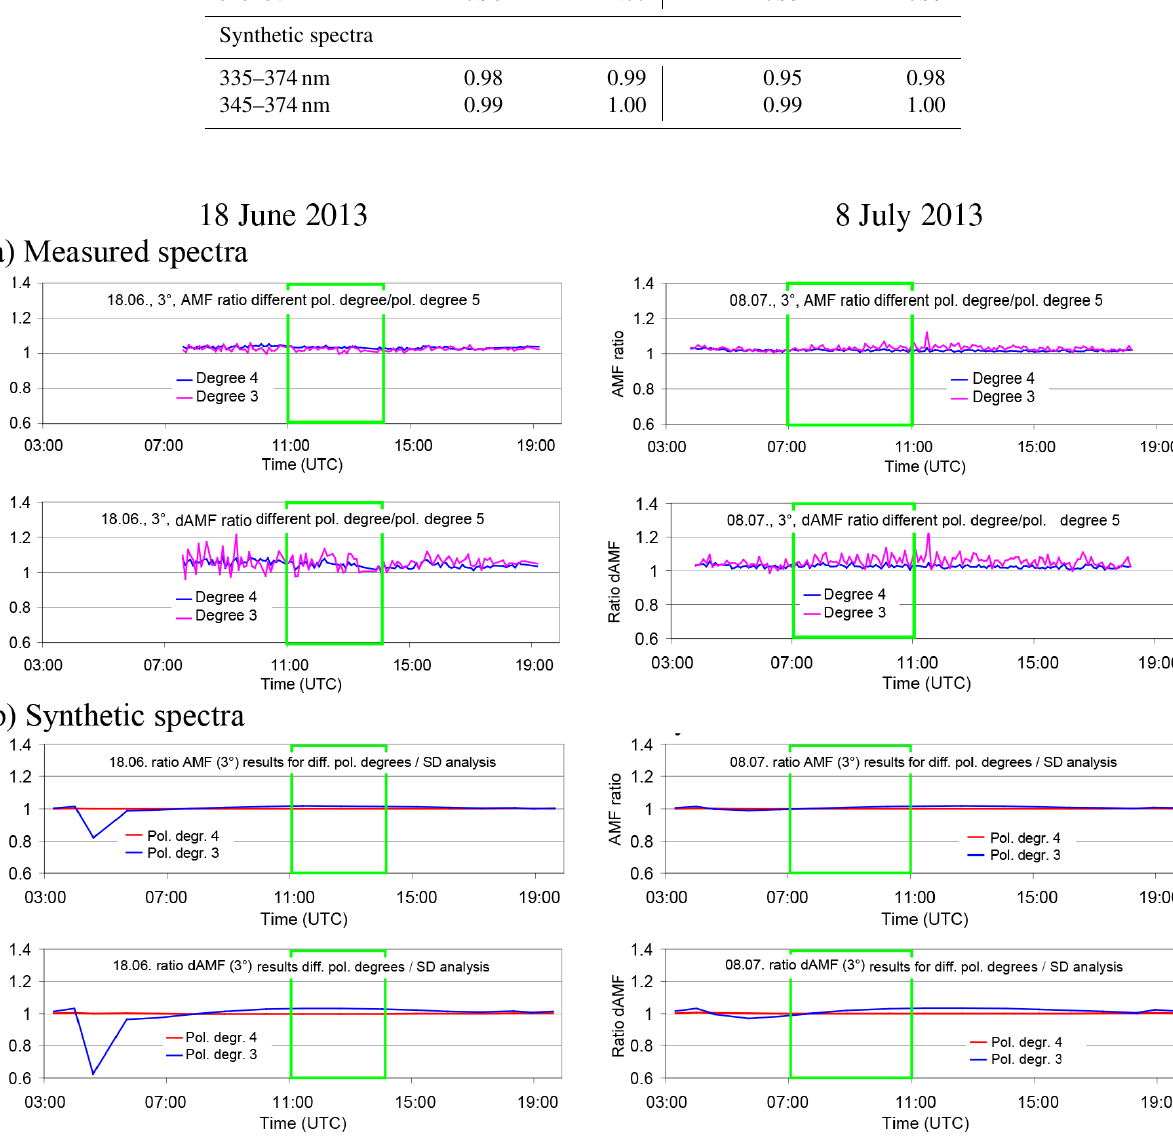
Figure A16. Ratios of the O 4 (d)AMFs derived for different polynomials vs. those for the standard analysis (polynomial degree 5) for both selected days ( a : results for spectra measured by the MPIC instrument; b : results for synthetic spectra when taking into account the temperature dependence of the O 4 cross